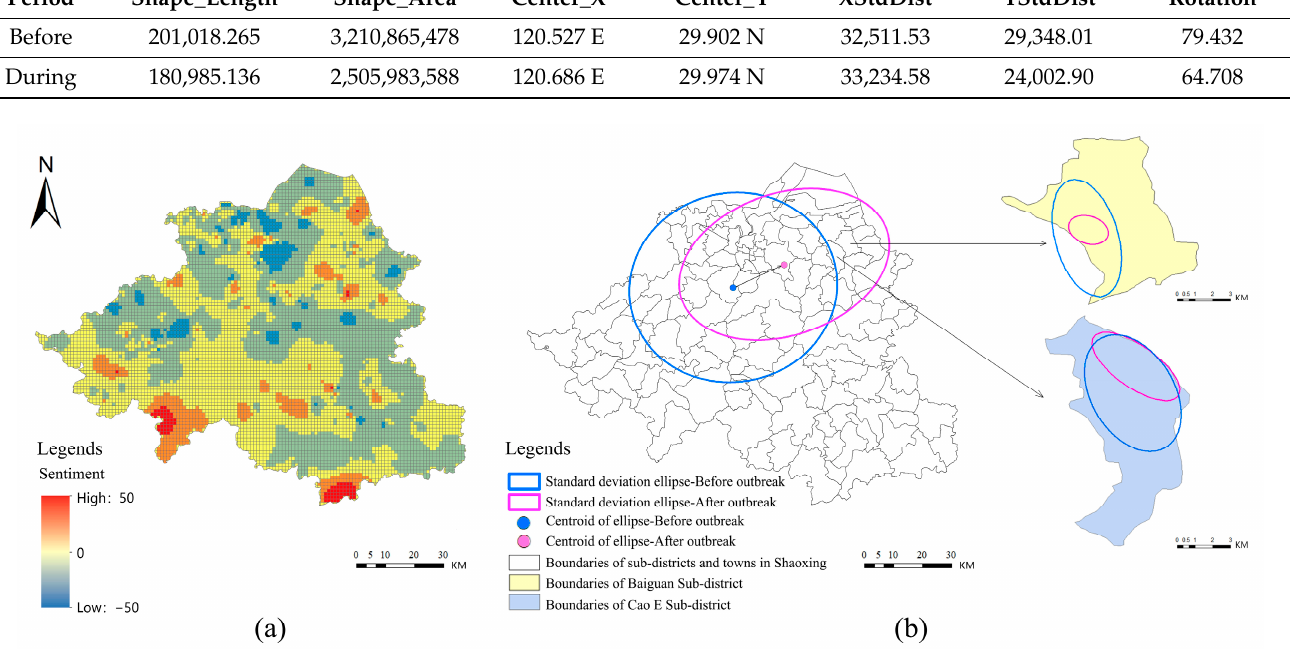
Figure 8. Spatial-temporal evolution of public sentiment before and after the COVID-19